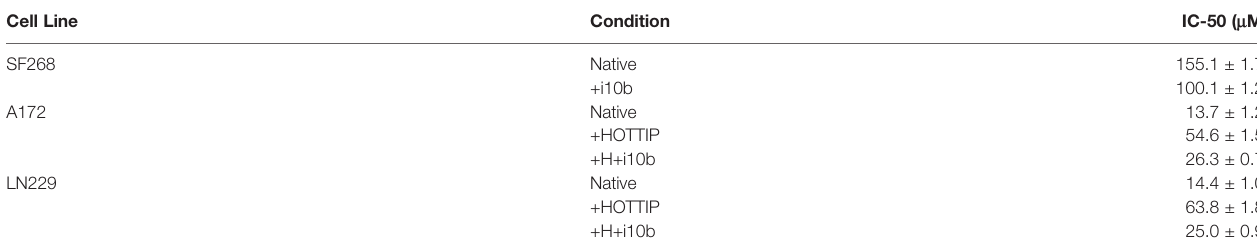
TABLE 1 | IC-50 values of glioma cells against